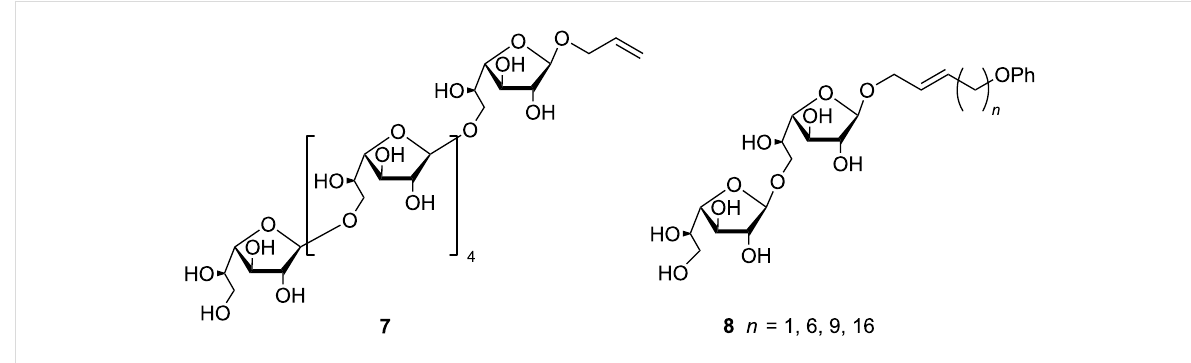
Figure 2: Examples of glycobiological tools synthesized from compound 5 [29-31].